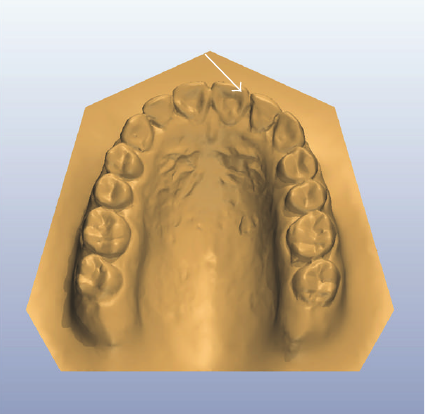
Figure 11: After treatment 3-dimensional model palatinal